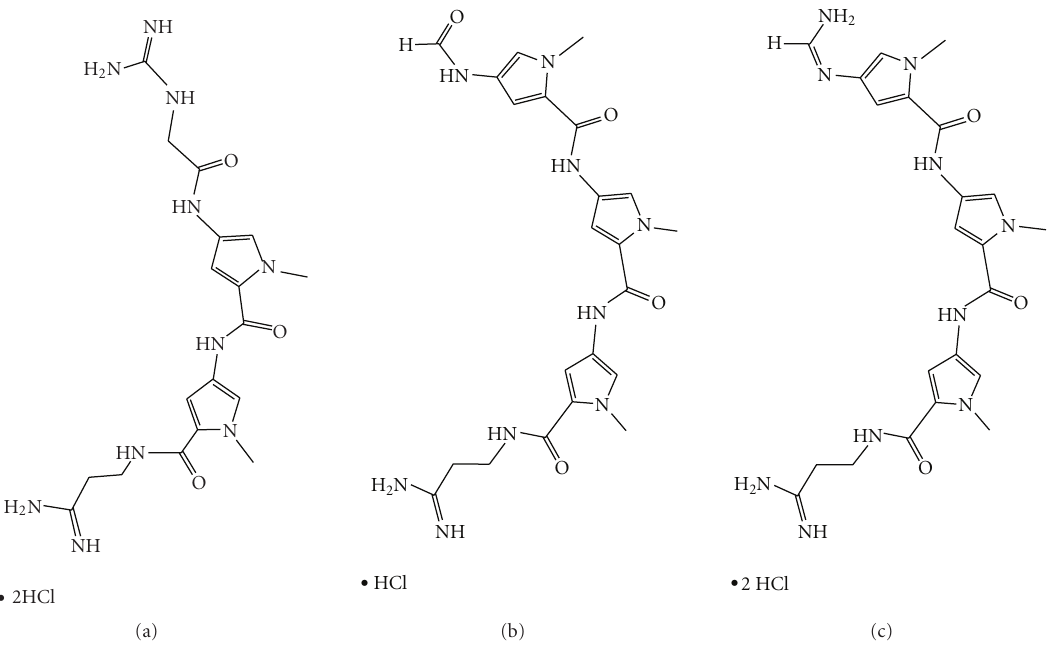
Figure 1: (a) Chemical structures of netropsin, (b) distamycin A, and (c) compound 1